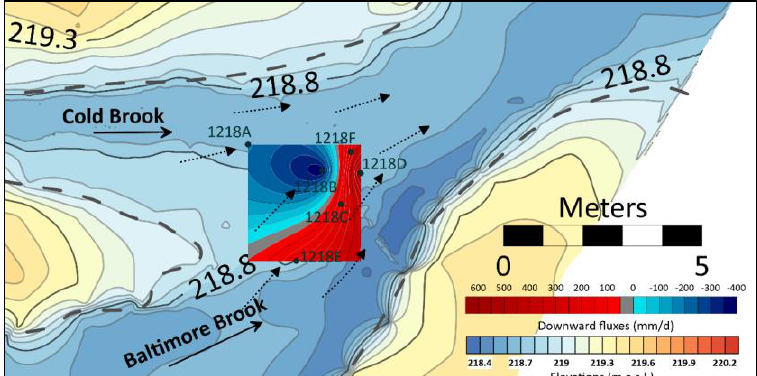
Figure 11. Vertical hyporheic fluxes (mm/day) for December 2018, derived from temperature profiles. Grey contour represents an interpolated transitional zone. Confluence margins (grey dotted lines) refer to relatively high-flow condition.